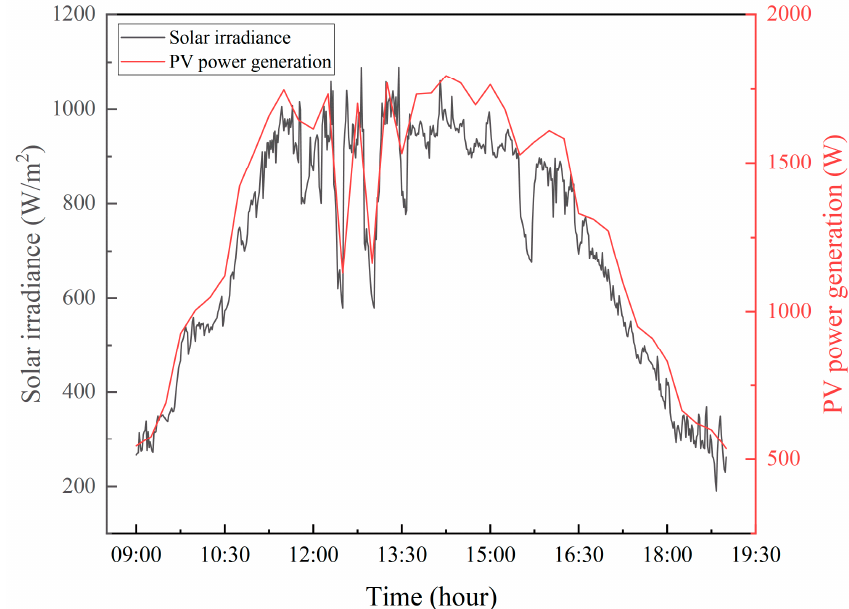
Figure 7. Irradiance and PV power generation changing curve over time. The maximum power generation of the photovoltaic power generation module may reach 2.01 kW, the average power generation is 1.29 kW, and the daily total power gener ‐ ation is about 12.9 kWh. The relationship curve between irradiance and photovoltaic power is shown in Figure 7. There are two main possible uncertainties in the data shown in the figure. The first one is the data acquisition error caused by the irradiance sensor, and the second one is the error generated when calculating the formula of the original data collected. However, the error caused by the above factors is within 5%, which is ac ‐ ceptable according to industry standard. 2.3. Power Generation Efficiency Optimization of PV Power Generation System The photovoltaic cells work based on the principle of semiconductor photovoltaic effect [106]. When the semiconductor is irradiated by sunlight, the electrons and holes will be moved to different sides and accumulate at both ends of the PN junction to form an electromotive force due to the negative and positive charges. The equivalent circuit of the photovoltaic cell is shown in Figure 8, and Equation 11 presents the mathematical model, such that: Figure 8. Equivalent circuit diagram of photovoltaic cell.